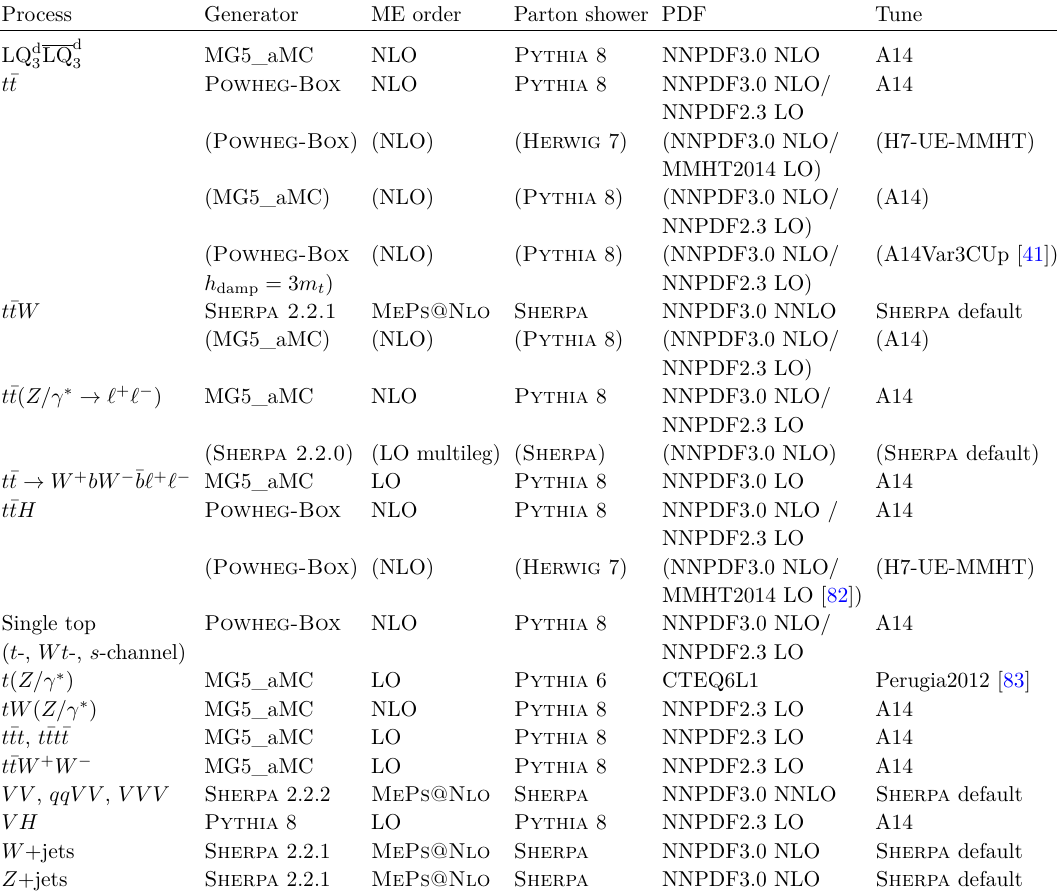
Table 1. The configurations used for event generation of signal and background processes. The samples used to estimate the systematic uncertainties are indicated in parentheses. V refers to production of an electroweak boson ( W or Z/γ ∗ ). The matrix element order refers to the order in the strong coupling constant of the perturbative calculation. If only one parton distribution function is shown, the same one is used for both the ME and parton shower generators; if two are shown, the first is used for the ME calculation and the second for the parton shower. Tune refers to the underlying- event tune of the parton shower generator. MG5_aMC refers to MadGraph5 _aMC@NLO 2.2, 2.3, or 2.6; Pythia 6 refers to version 6.427 [78]; Pythia 8 refers to version 8.2; Herwig++ refers